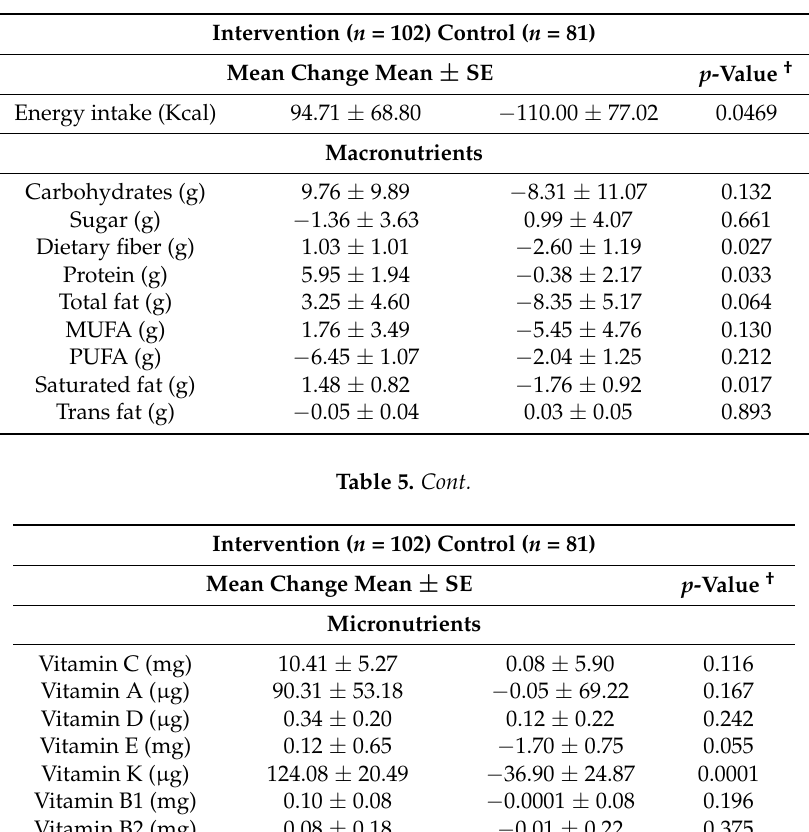
Table 5. Between-group differences (intervention versus control) in mean change of total energy (kcal/day) and macro-and micronutrient intakes (g/day) among school-aged children ( n = 183).